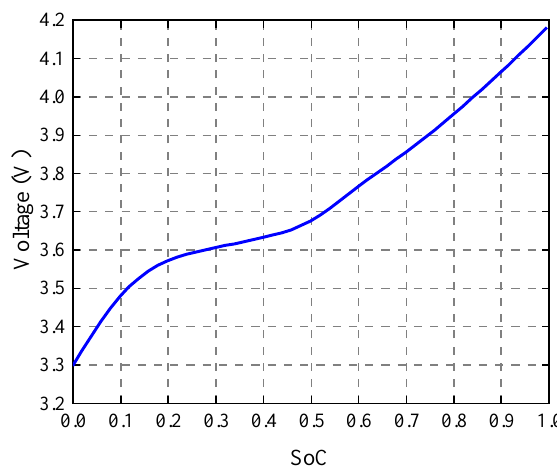
Figure 2. SoC-OCV mapping curve.